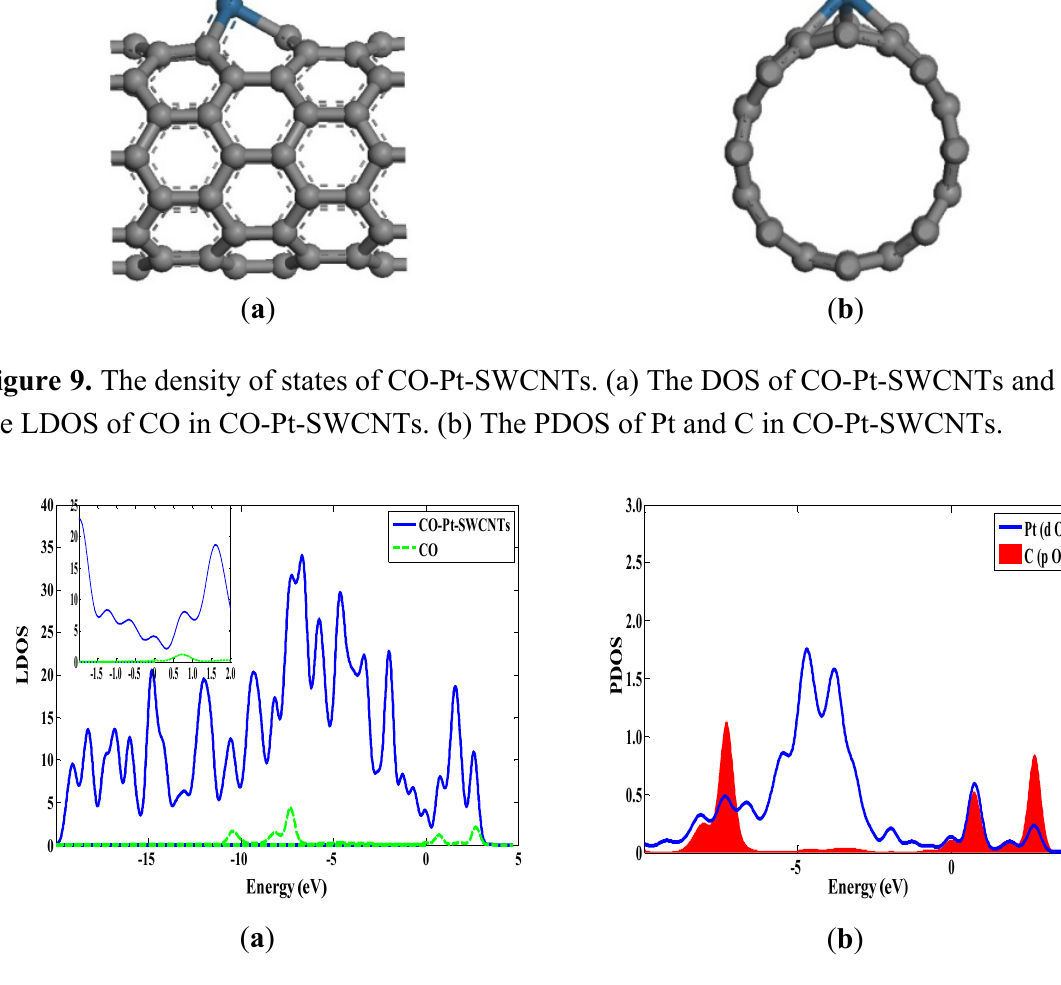
Figure 10. Frontier orbital energy level of CO-Pt-SWCNTs. ( a ) HOMO (–4.797 eV); ( b ) LUMO (–4.455